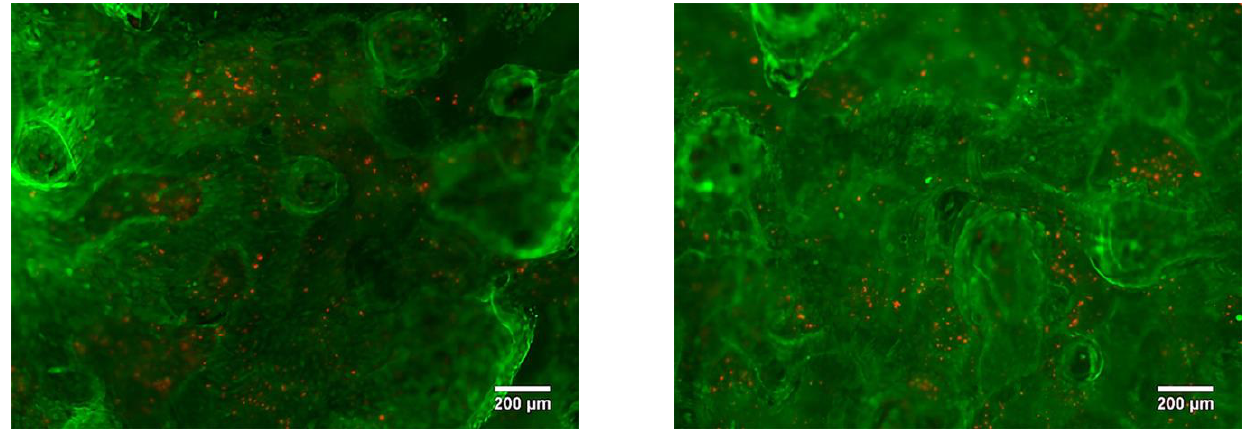
Figure 19. Porous Ti-45wt.% Nb sample LIVE/DEAD stained with Calcein AM/PI after 3 days of incubation.